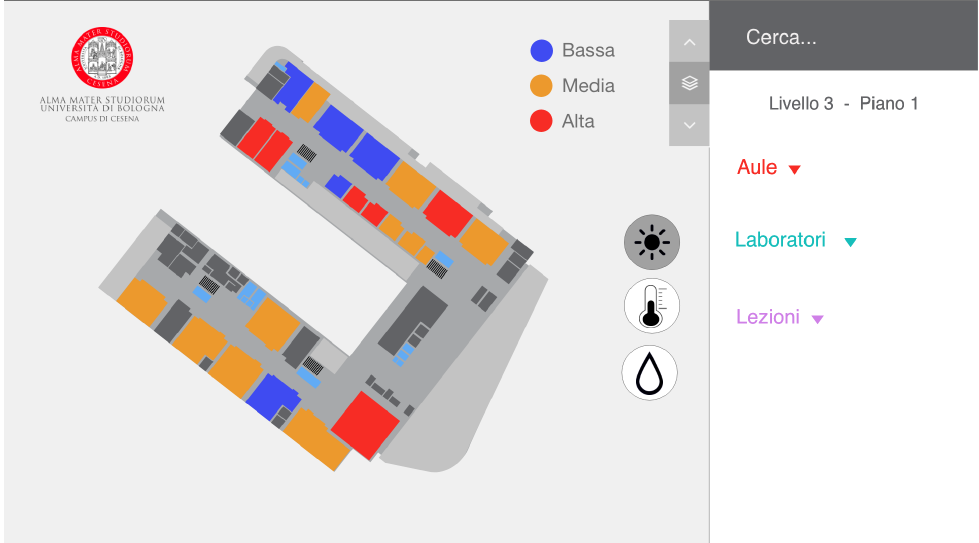
Figure 7. The UI of the second prototype with the brightness icons selected. Each space is colored based on the current data gathered by the brightness sensors. A legend for the color is also displayed to help the users and avoid